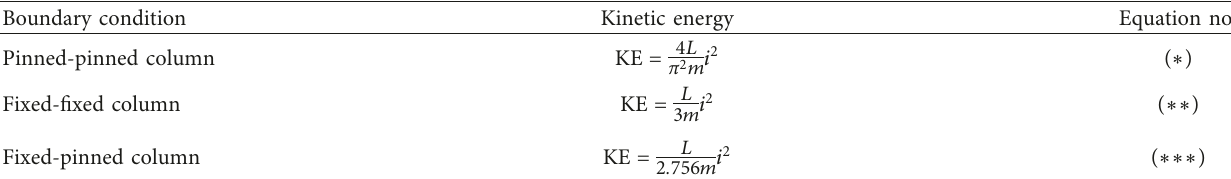
Table 4: Equations for the kinetic energy of the column induced by the blast [9].